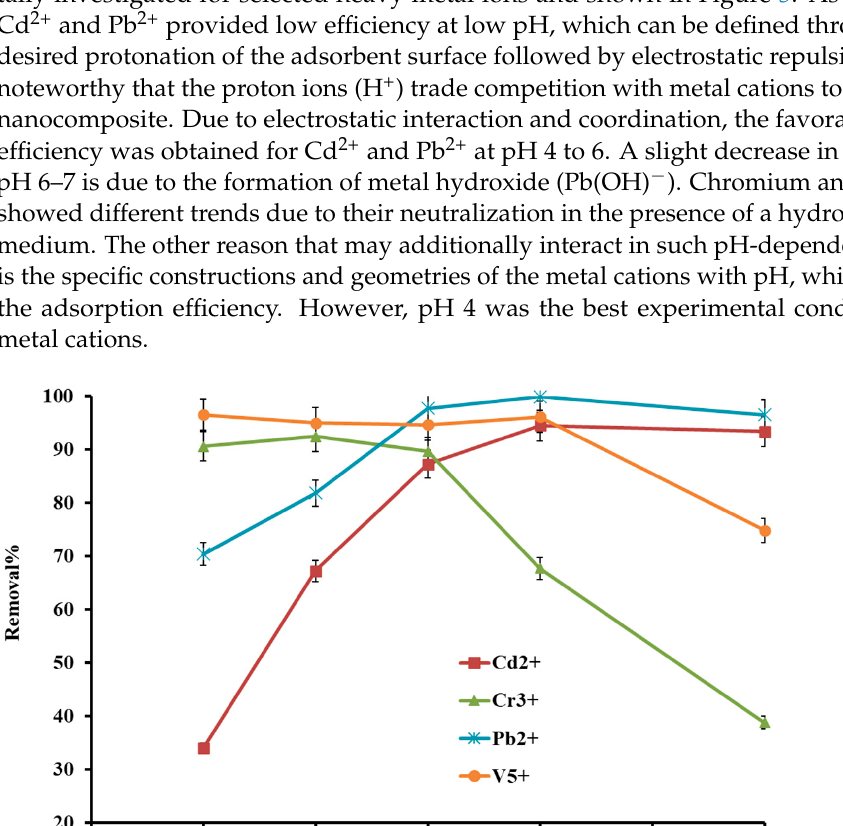
Figure 4. Influence types of materials on adoption efficiency.